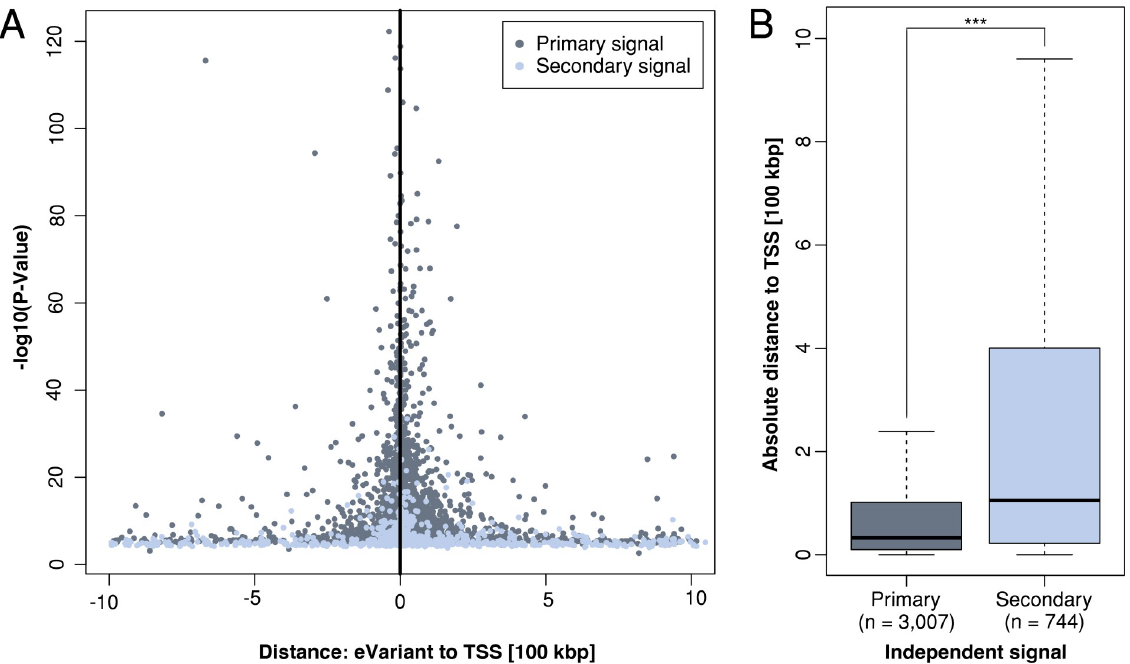
Fig 2. Genomic localization of eVariants. ( A ) The distance of the most significant eVariant to the transcription start site (TSS) of the respective eGene is plotted against the significance of the association ( − log10 P-Value). Shown are the results of the primary analysis (primary signal, dark grey) and the most significant eVariants from the conditional analysis (secondary signal, light grey) for each eGene. Negative/ positive distances denote that the variant is located upstream/downstream of the TSS with regard to the direction of transcription. ( B ) Boxplot of the absolute distance of primary and secondary signals to the TSS. Significance was assessed by the Mann-Whitney-U-Test (P-value < 8.05 x 10 − 43 ).